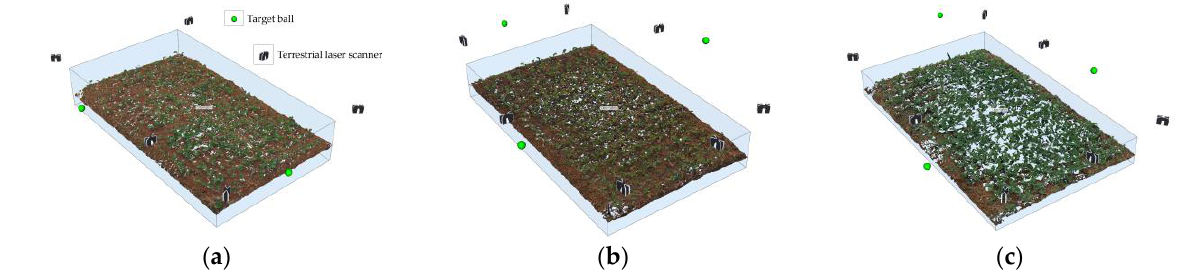
Figure 1. Field overview of rapeseed under three scenarios. ( a ) Preview of the 3D point cloud acquisition scene of Rapeseed-01 in the field; ( b ) Rapeseed-02; ( c ) Rapeseed-03.